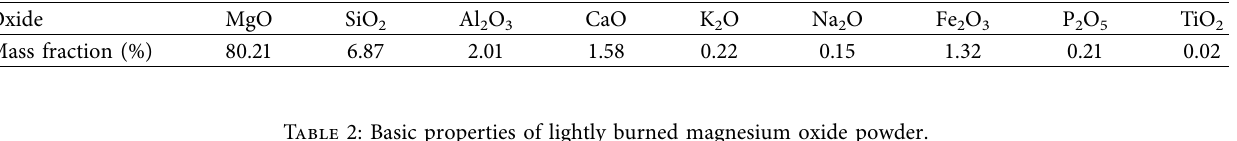
Table 1: Chemical composition of lightly burned magnesium oxide powder.